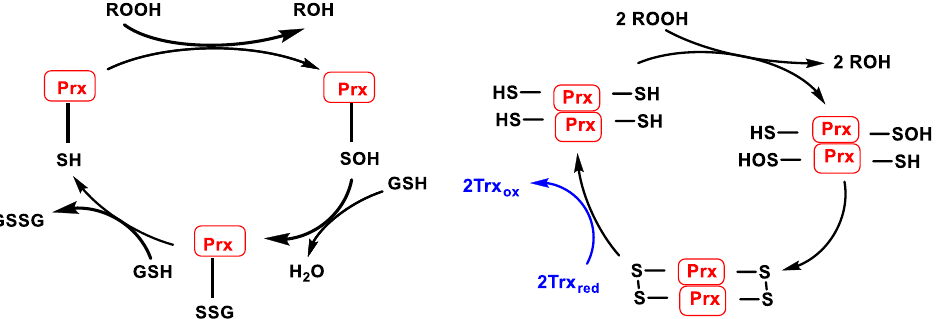
cycle of typical Prx (2-Cys-Prx). Figure 17. ( Left ): Catalytic cycle of Prx containing 1 catalytic cysteine (1-Cys-Prx). ( Right ): Catalytic